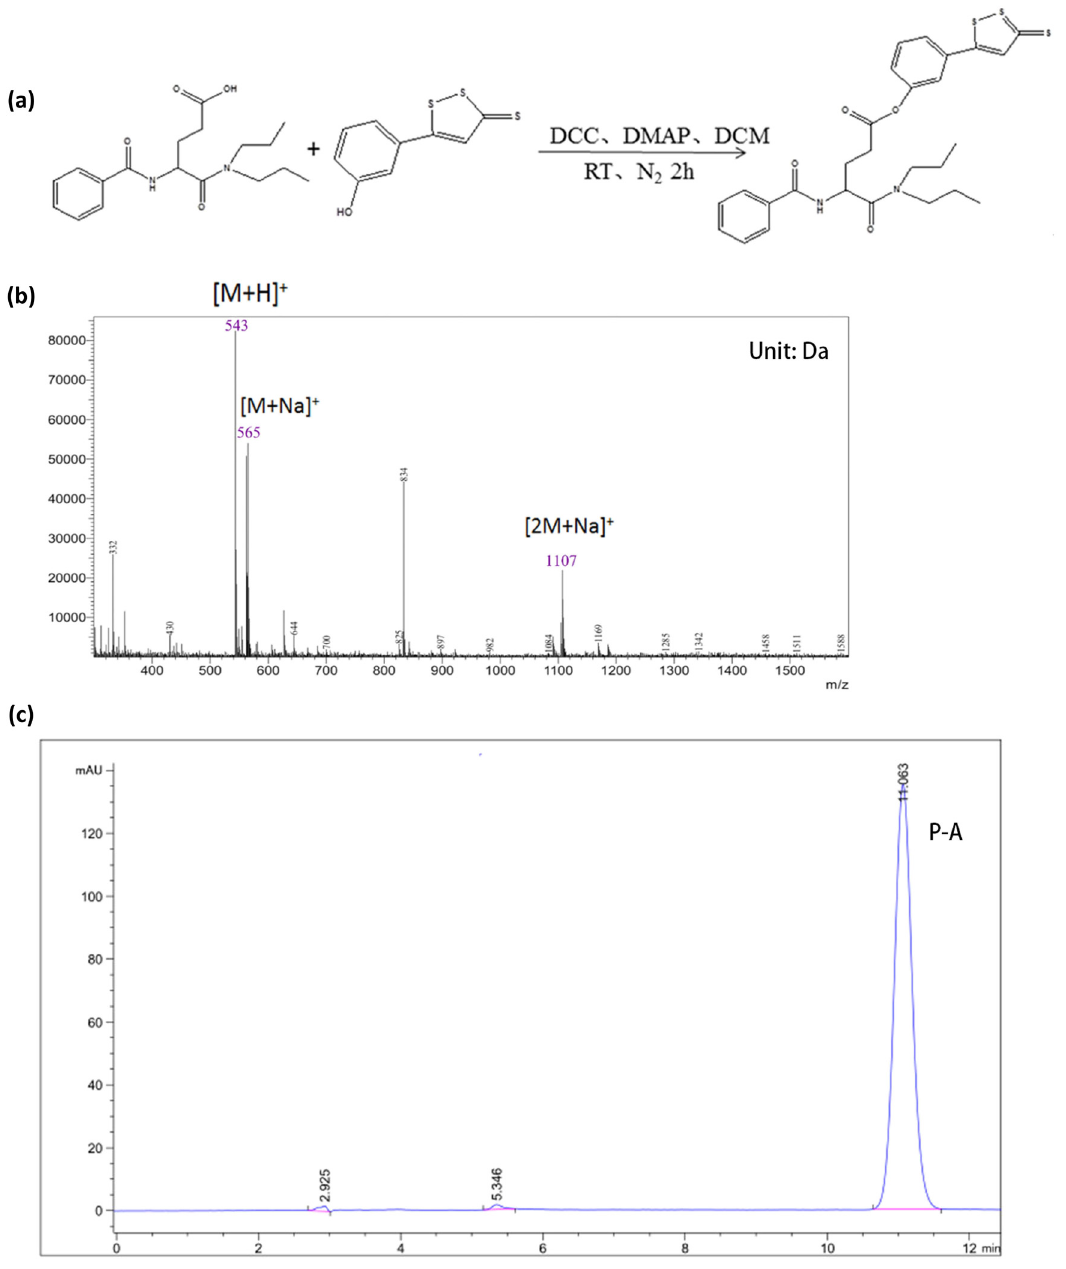
Figure 1: P - A was successfully synthesized. ( a ) The method of synthesizing P - A. ( b ) MS of P - A. The molecular weight of P - A was 542 by MS. The molecular weight was 543, indicating the combination of P - A and H. The molecular weight was 565, indicating the combination of P - A and Na + . The molecular weight was 1,107, indicating the combination of 2 molecules of P - A and Na + . ( c ) P - A has higher purity and less impurity content, as well as a single peak was showed by